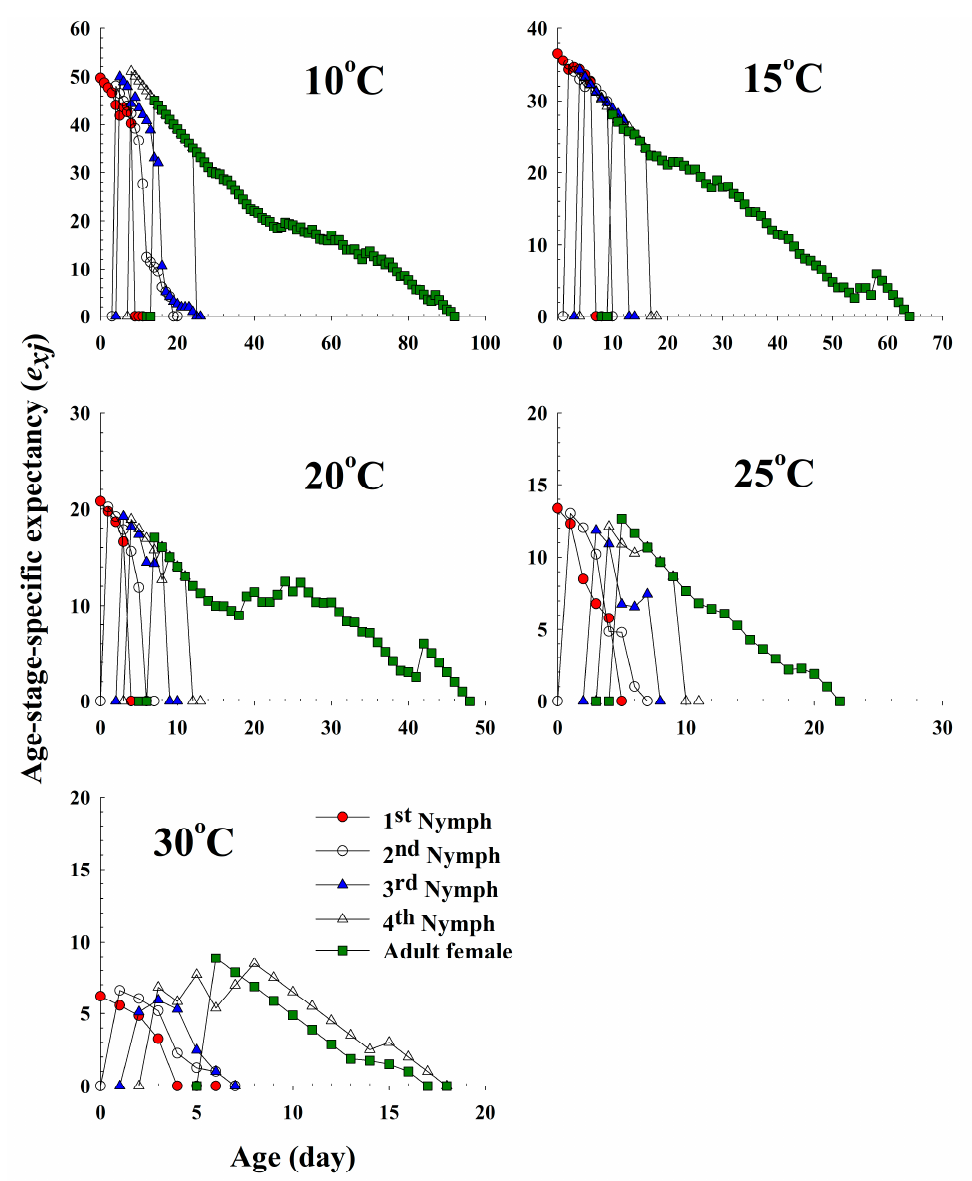
Figure 4. The age-stage life expectancy ( e xj ) of Acyrthosiphon pisum in response to different temperature conditions.